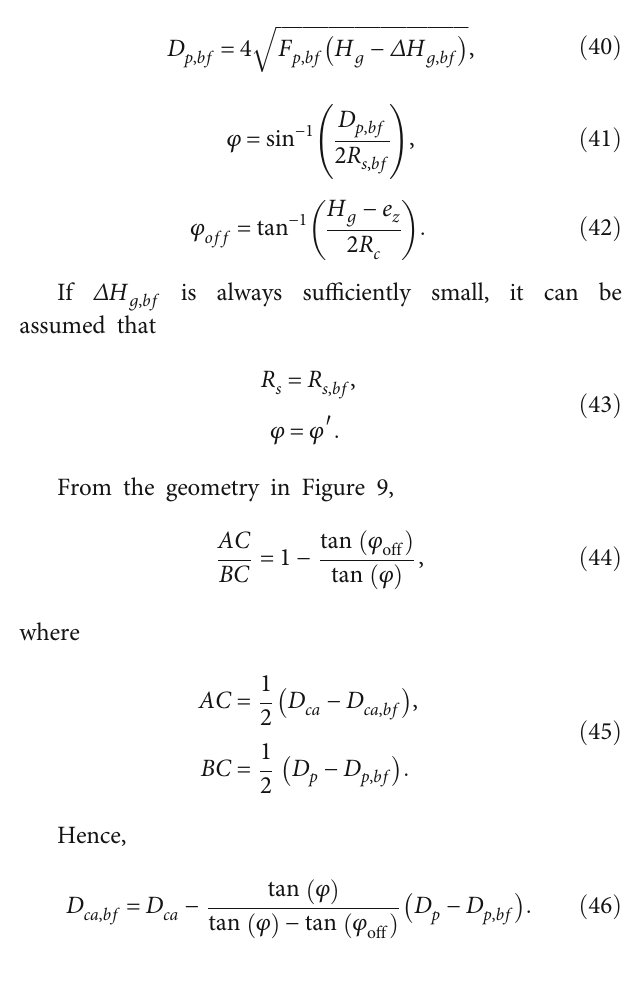
within the o ff set aperture; F best- fi t focal length and the vertical deviation; and φ is the slope of the best- fi t parabola at the point intersecting with the parent aperture in the x Figure 9,